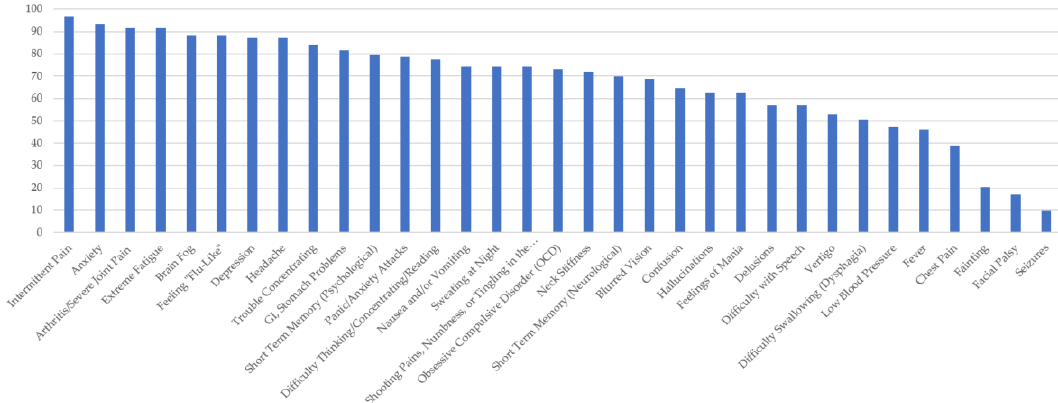
Figure 3. Percentage of Respondents with Anaplasmosis Reporting Specific Symptoms.